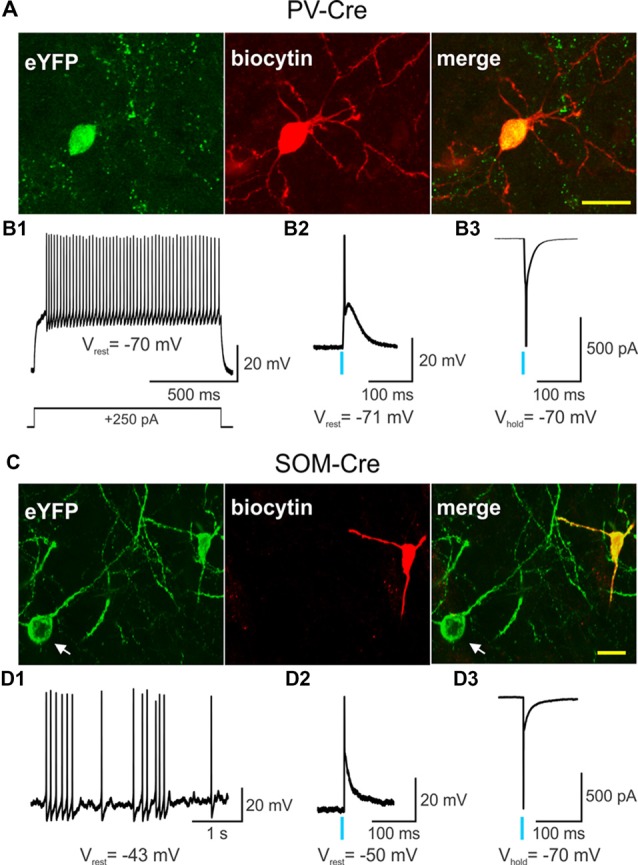
Single action potentials are generated by a brief light pulse in parvalbumin (PV)- and somatostatin (SOM)-expressing interneurons. Confocal images of biocytin-filled PV- (A) or SOM-expressing (C) interneurons (red) that also express eYFP from 2 months-old wildtype (WT) PV- and SOM-Cre mice. In (C) the cell body of a SOM-expressing interneuron that also expresses eYFP but was not recorded from is visible (white arrow). Scale bar = 20 μm. (B1) Voltage response to a depolarizing, suprathreshold current injection in a PV-expressing interneuron that also expresses channelrhodopsin-2 (ChR2) and eYFP. Recordings of a PV-expressing interneuron co-expressing ChR2/eYFP in current-clamp (B2) and in voltage-clamp (B3) modes show that a brief light pulse (0.5 ms, 470 nm, 3 mW) produces an action potential. The action potential in the bottom trace was truncated for the figure. (D1) Spontaneous firing of a SOM-expressing interneuron that expresses ChR2/eYFP in current-clamp mode. A brief light pulse (0.5 ms, 470 nm, 3 mW) produces an action potential in a SOM interneuron recorded in current-clamp (D2) and in voltage-clamp (D3) modes. The action potential in the bottom trace was truncated for the figure. In this and in subsequent figures, a blue vertical line indicates the delivery point of a single blue light stimulation pulse.